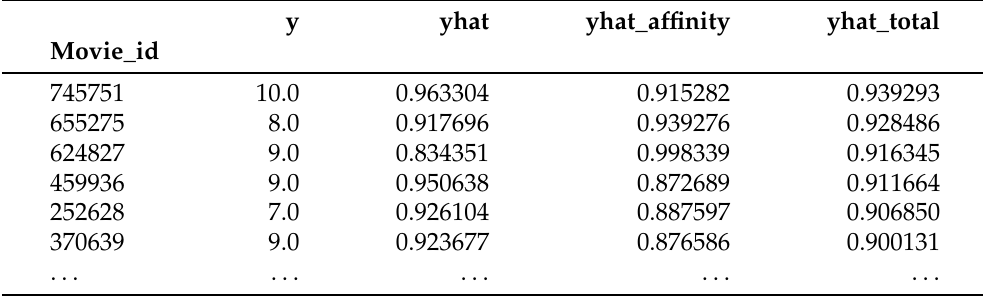
Table 7. Dataframe predictions for the user where the predictions for the selected user are displayed sorted by prediction (highest prediction rank on top). The shape is (585, 4), where 585 is the number of movies rated by the user from the movie set, and 4 is the number of columns added for predictions.